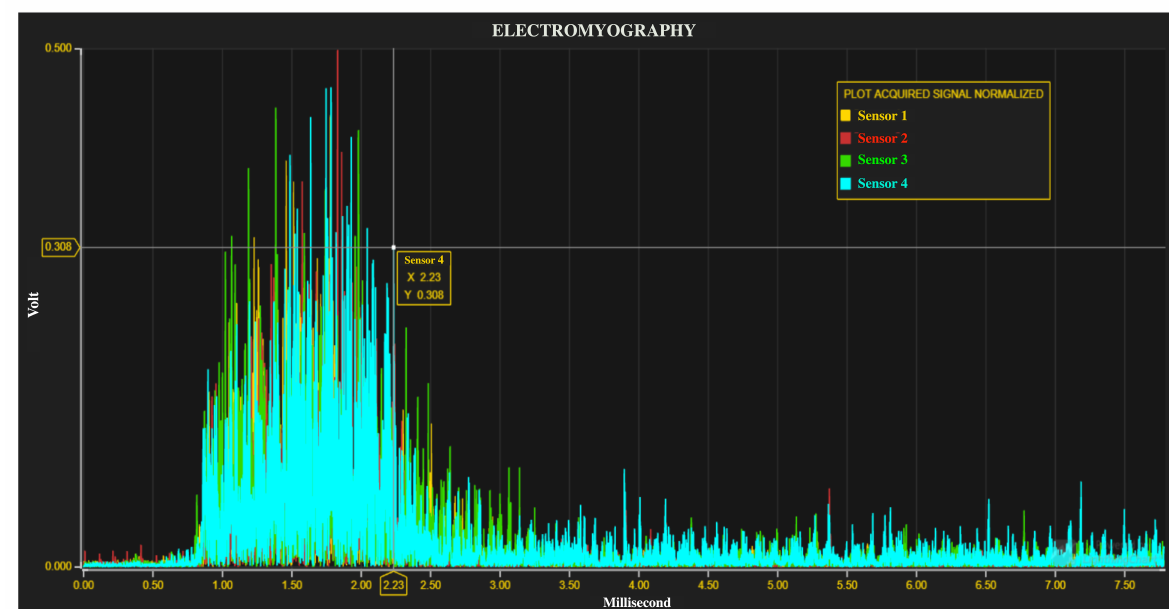
Figure 10. Web viewer for biopotential signals: an example of rectified EMG